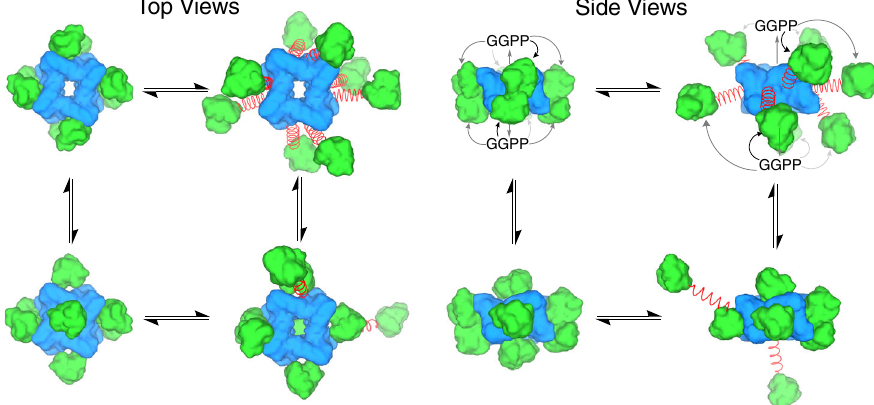
Fig. 5 Possible conformations of the full-length PaFS octamer. Prenyltransferase domains (blue) and cyclase domains (green) are represented by molecular surfaces generated with Chimera; the fl exible 70-residue linker is represented by a red spring (this color scheme corresponds to the primary structure summary in Fig. 1). Compact octamer conformations are modeled by symmetry expansion of classes A and C, class B, or capping cyclase domain positions shown in Fig. 3. Cyclase domains in splayed-out positions are modeled with an average distance of 60 Å from the prenyltransferase core. Where all cyclase domains are splayed-out, each is 60 Å from the octameric core; where only two cyclase domains are splayed-out, they are each 120 Å away. Possible trajectories of GGPP transit are illustrated in selected side view structures, in which GGPP generated by the prenyltransferase domains diffuses out of the central pore of the oligomer into the active site of one of the nearby cyclase